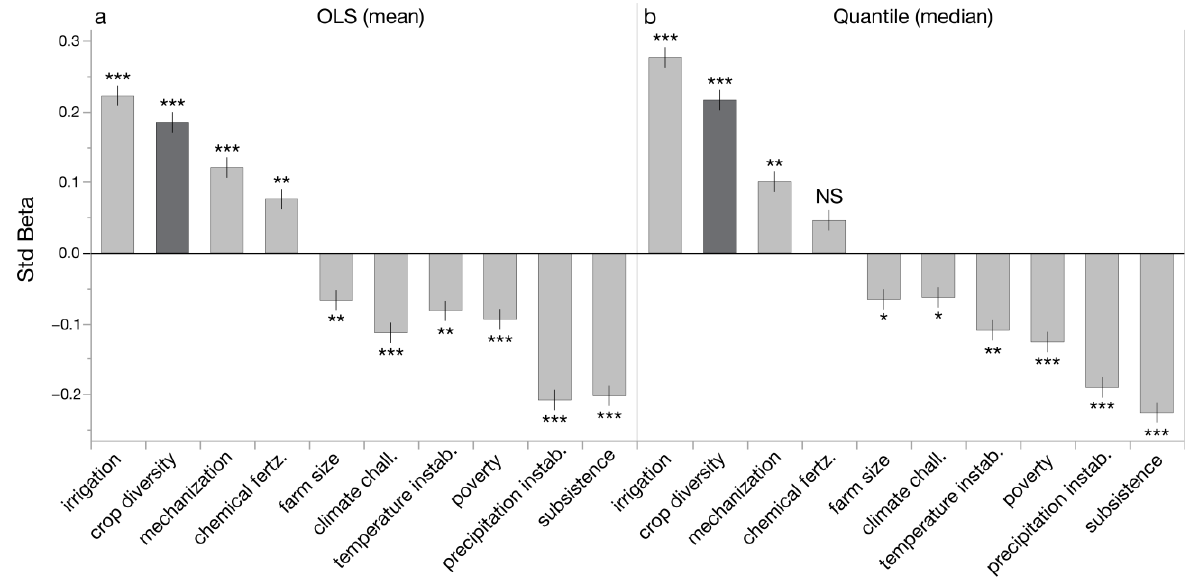
Figure 3. Results of Model 2 showing standardized effects of crop diversity (shaded dark) and other predictors (shaded gray) on crop revenue stability (relative) in southern Mexico for ( a ) standard ordinary least squares (OLS) and ( b ) quantile (median) regressions. All variables were transformed and standardized (z-scored) to meet model assumptions and to facilitate comparison of results (for transformation details, see end of Section 2.5). * p < 0.05, ** p < 0.01, *** p < 0.001, NS = not statistically significant.